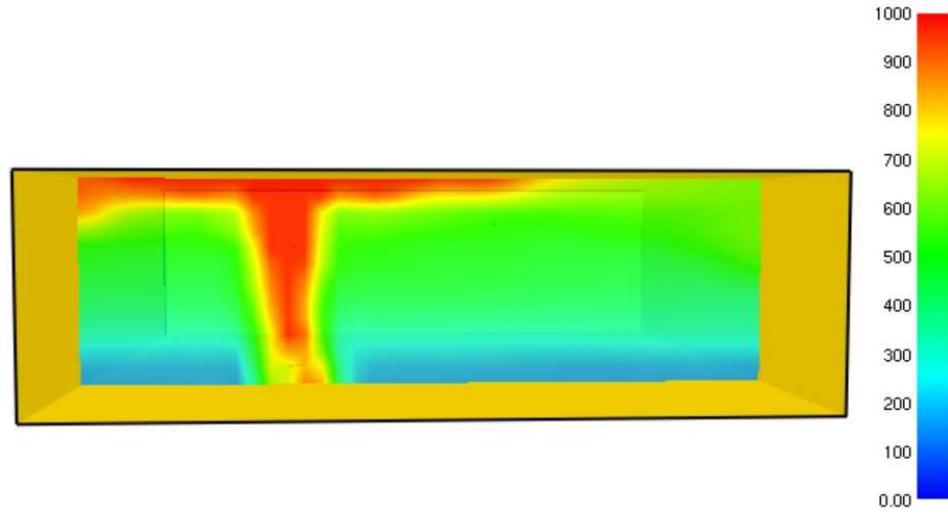
Figure 4. Temperature field (°C) of the Heptane jet fire at t = 78.6 s.